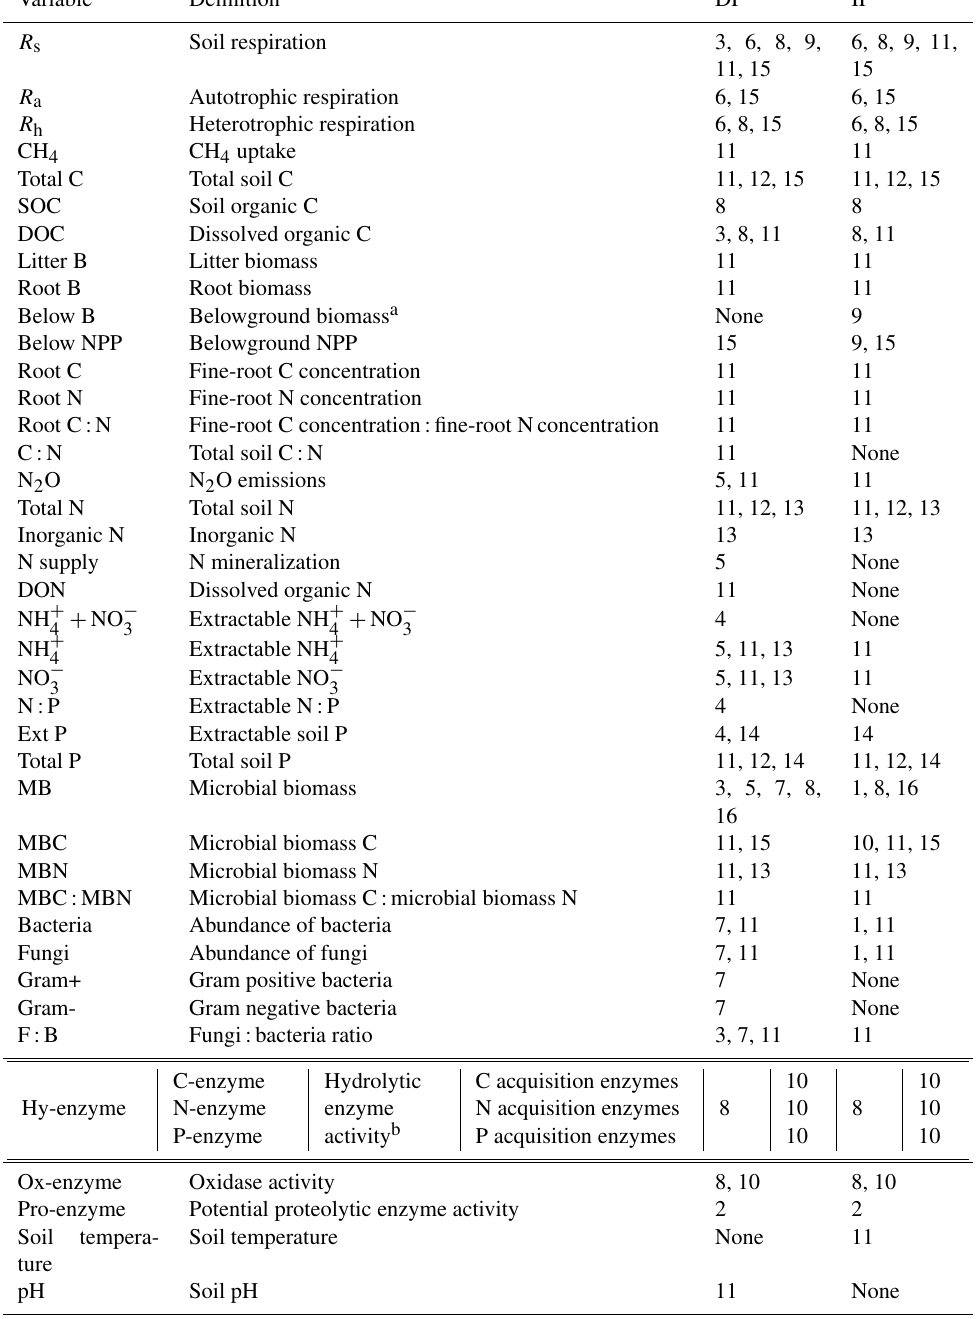
Table 2. List of soil variables and their definitions as analyzed in the meta-analyses. The numbers indicate the meta-analysis number corre- sponding to Table 1, examining the effects of decreased precipitation (DP) and increased precipitation (IP) on each soil variable.